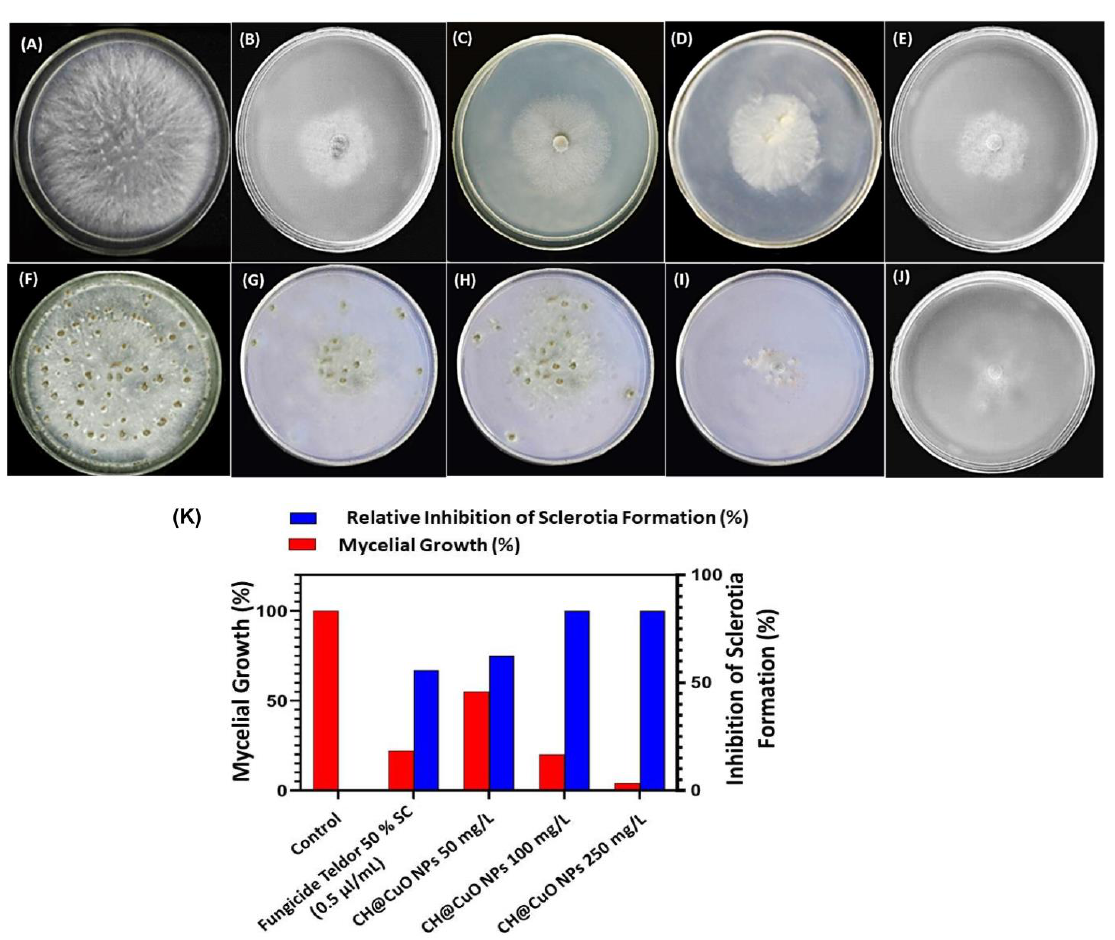
Figure 2. Inhibitory activity of CH@CuO against B. cinerea mycelial growth and sclerotia formation on PDA medium; non treated plates cultivated with B. cinerea (control) ( A ); plate treated with Teldor 50 % SC ( B ); treated plates with CH@CuO at 50 ( C ),100 ( D ) and 250 mg/L ( E ) after 8 days of incubation at 20 °C; no treated plates cultivated with B. cinerea (control) ( F ); B. cinerea plate treated with Teldor 50% SC ( G ); plates treated with CH@CuO at 50 ( H ), 100 ( I ) and 250 mg/L ( J ) after 21 days of incubation at 20 °C. Mycelial growth of B. cinerea and sclerotia ( K ) in response to treatments with CH@CuO NPs and the fungicide (Teldor 50% SC.).